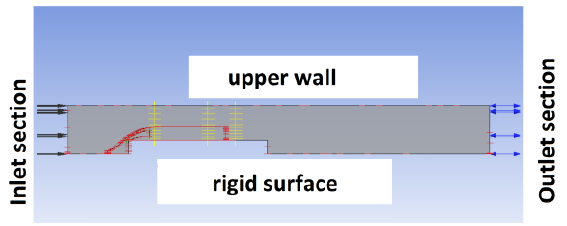
Fig. 7 . Side view of the geometry of the simulation area.